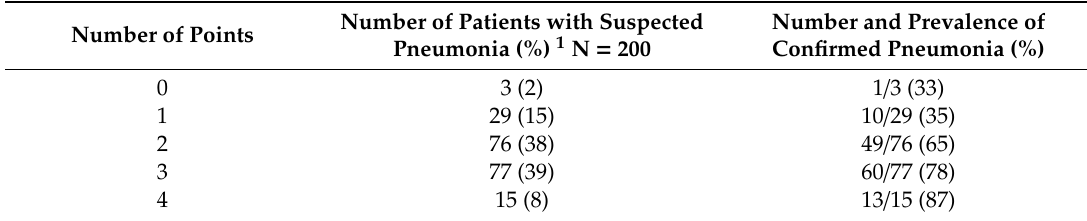
Table 3. Number of patients with suspected pneumonia and prevalence of confirmed pneumonia according to the